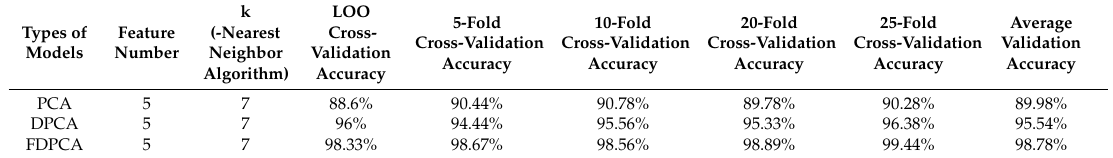
Table 3. The classification results of the three feature extraction